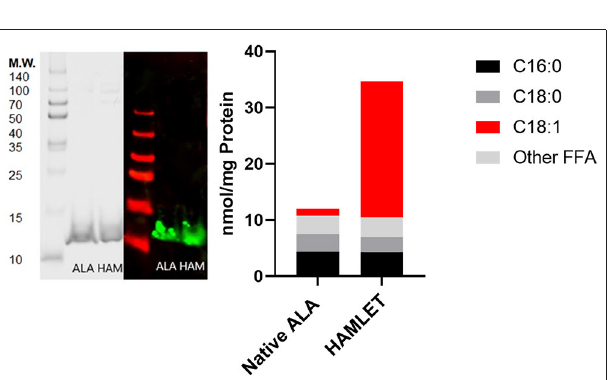
FIGURE 2 | HAMLET verification with SDS-PAGE gel, Western blot and uHPLC. Left: SDS-PAGE gel with Coomassie stain and Western blot for native (purified) α -lactalbumin and HAMLET protein. Right: Free fatty acid content per mg protein analyzed by UHPLC-MS/MS comparing substrate free fatty acid (nmol) associated with mass (mg) of native α -lactalbumin and HAMLET after oleic-acid conditioned anion-exchange chromatography. ALA, α -lactalbumin; HAM,